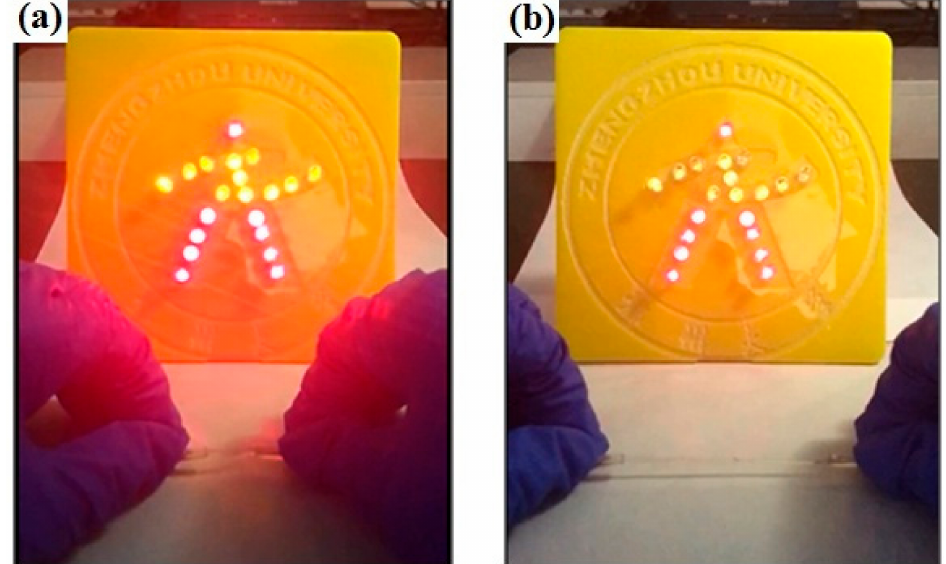
Figure 8. Stretching the stretchable cable based on SNP-reinforced ionogel in a light emitting diode circuit: ( a ) stretchable cable based on SNP-reinforced ionogel without stretching; ( b ) stretching the stretchable cable based on SNP-reinforced